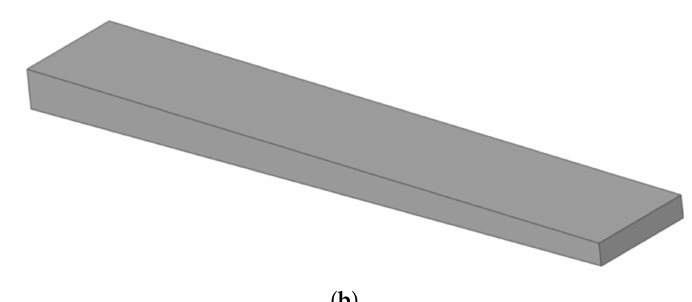
Figure 1. Geometric characteristics of a tapered beam with linear tapering ratio c . ( a ) top view and front view, ( b ) 3D view of the tapered beam. L , b , T b and right-end beam’s